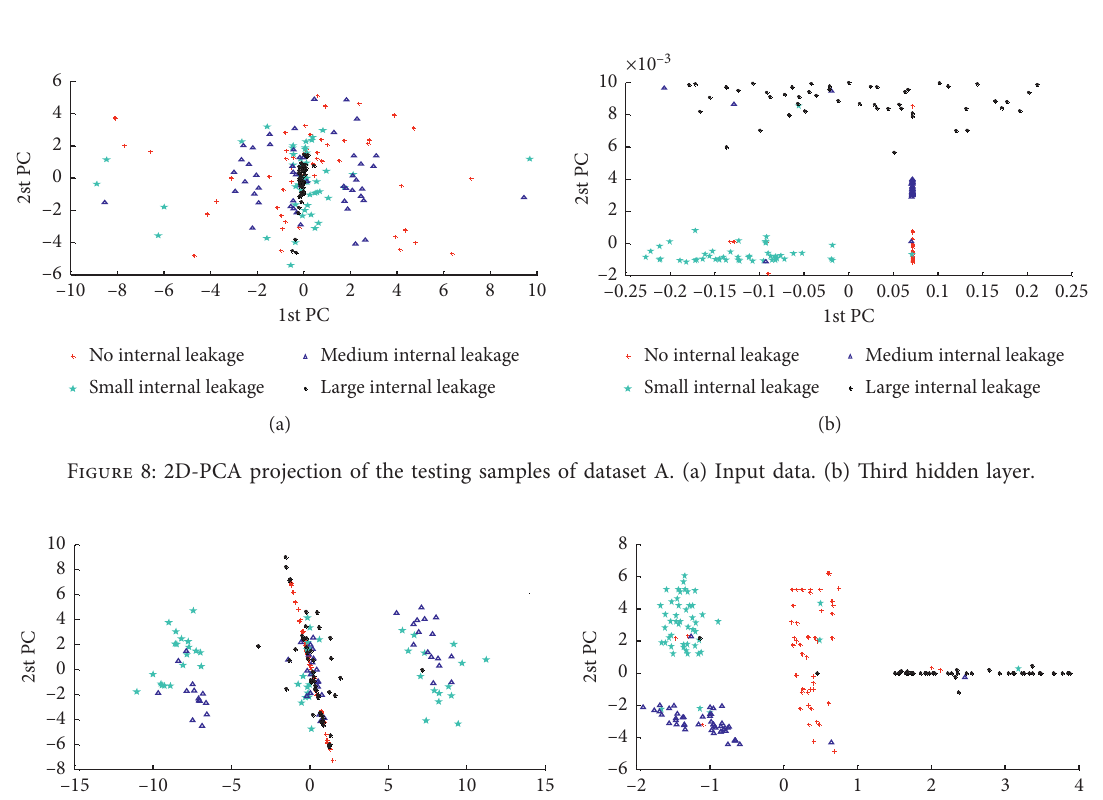
Figure 7: Average classification accuracy under different numbers of selected IMFs.